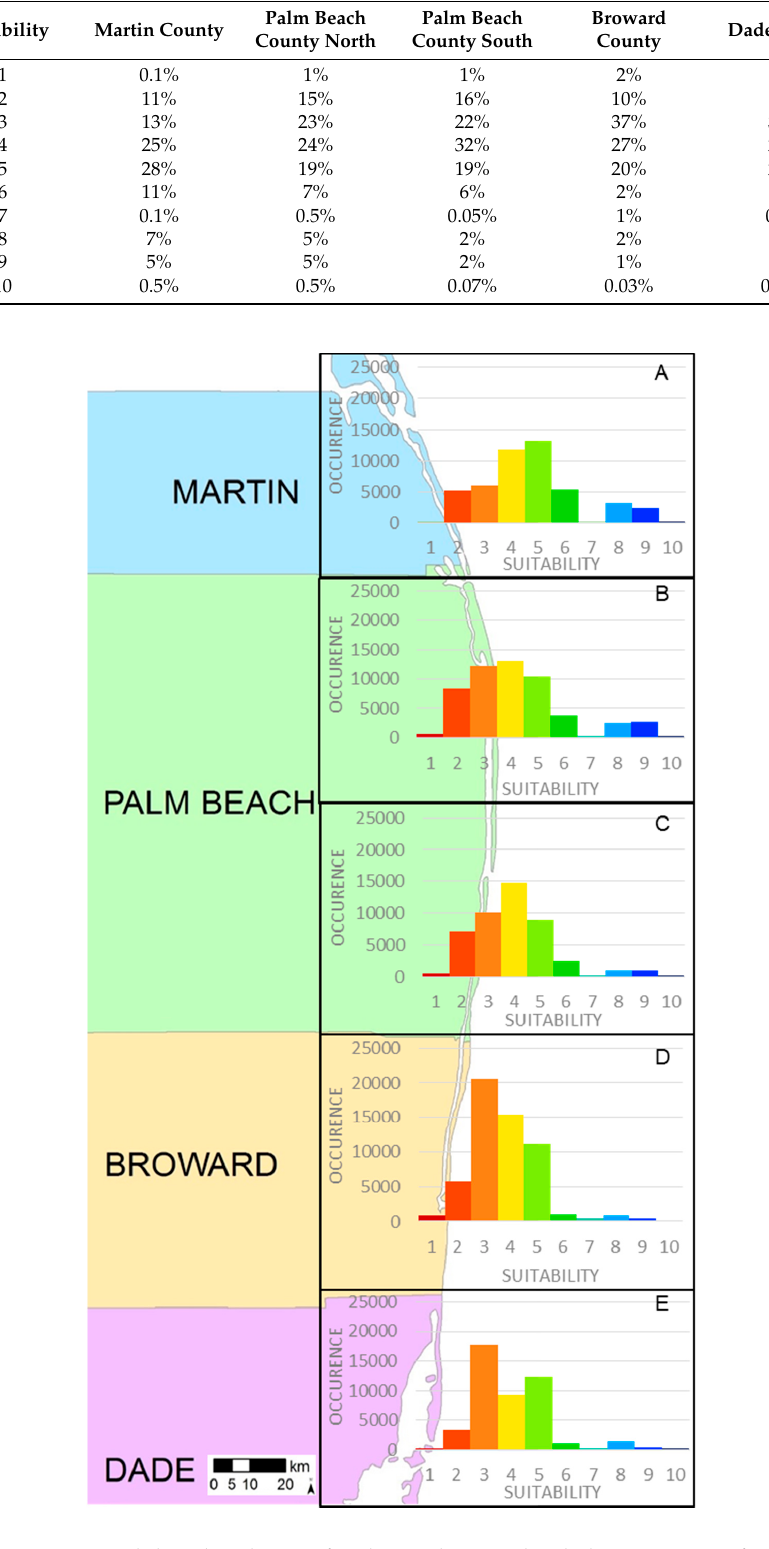
Figure 6. Nesting suitability distribution for the study area divided into sections for: ( A ) Martin County; ( B ) northern portion of Palm Beach County (area used in the model evaluation); ( C ) southern portion of Palm Beach County; ( D ) Broward County; and ( E ) a Dade County.